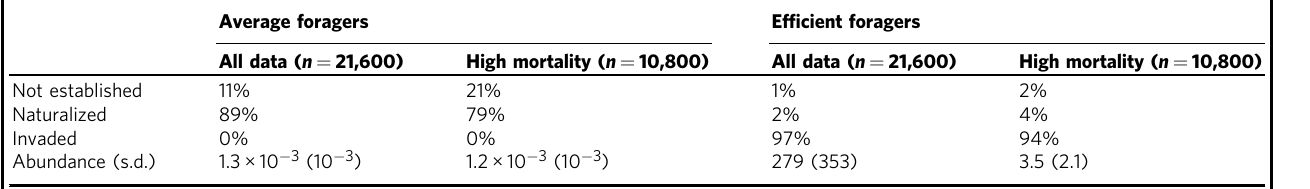
Table 2 Outcomes of introducing alien pollinators into pollination networks Average foragers